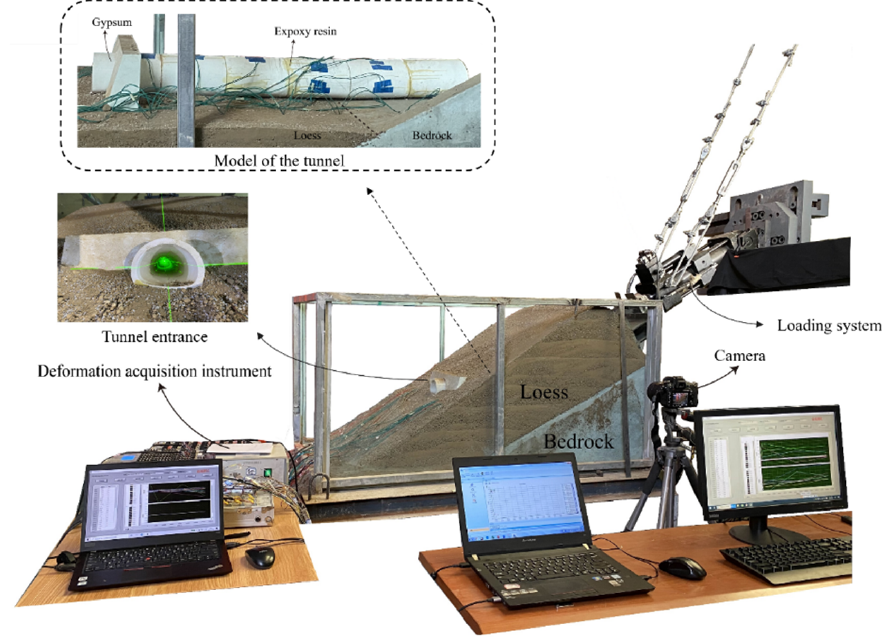
Figure 2. LTS model and loading method.